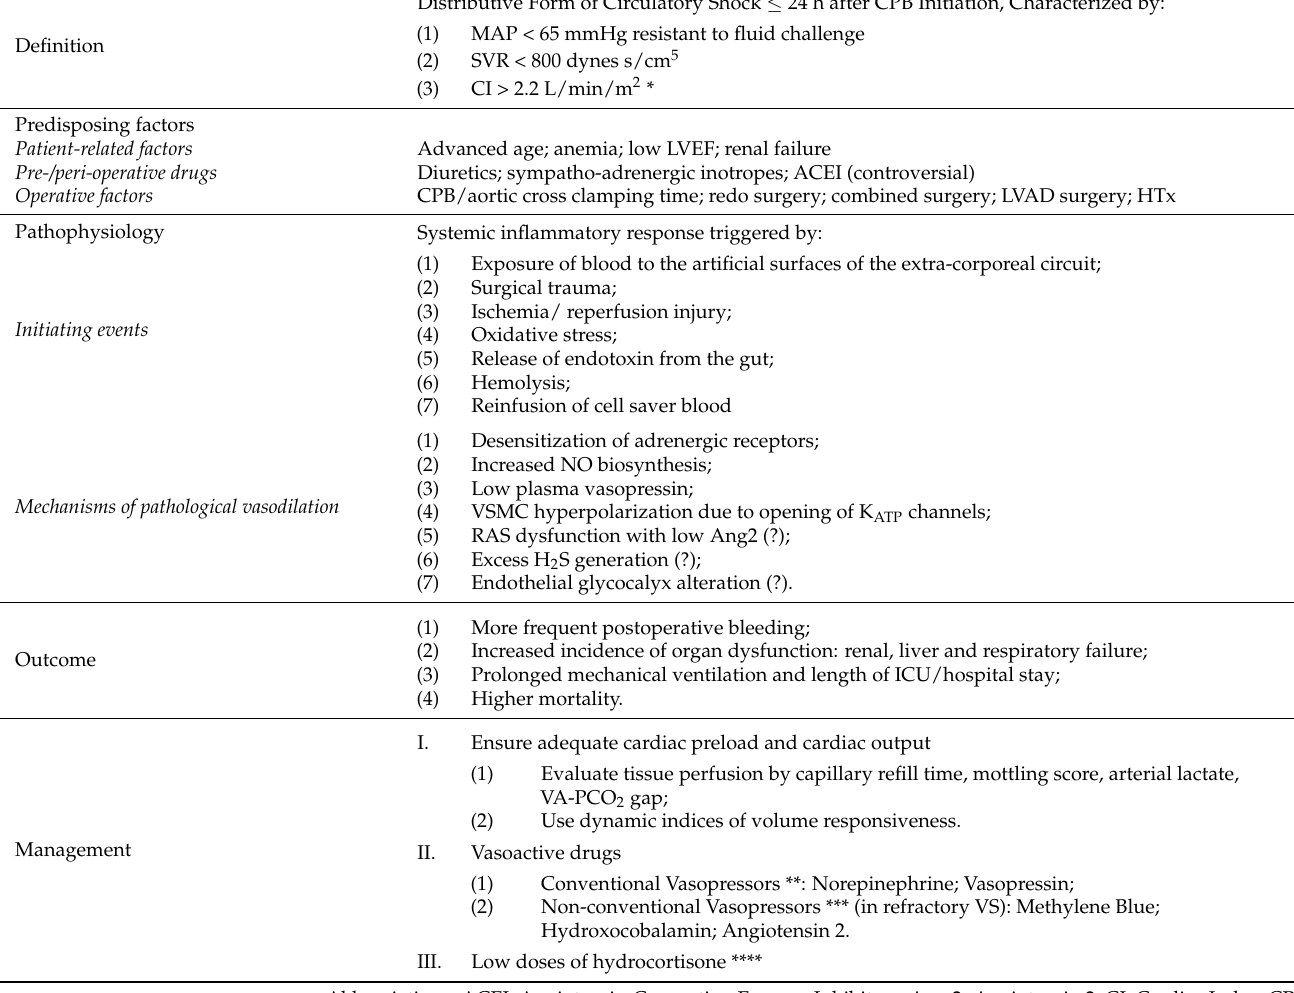
Table 1. Vasoplegic shock after cardiopulmonary bypass—main